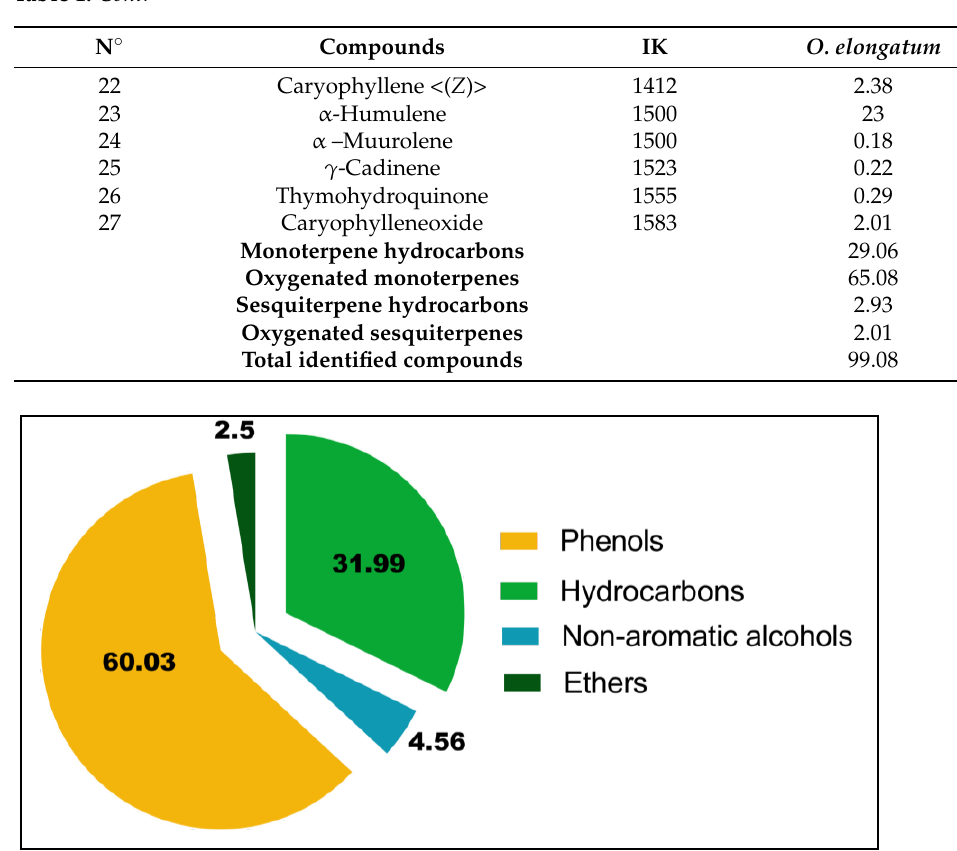
Figure 2. Percentage of the main chemical families of the EO of O. elongatum .